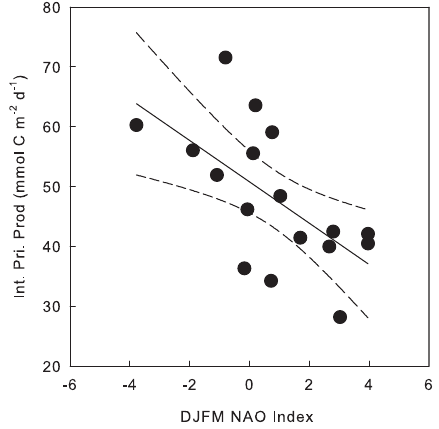
Fig. 7. Bivariate plot of euphotic zone integrated primary produc- tion (mmolCm − 2 d − 1 ) vs. winter NAO index. Solid line is the least squares Model II regression and the dashed lines are the are 95% confidence intervals. Correlation is significant at the P < 0 . 02